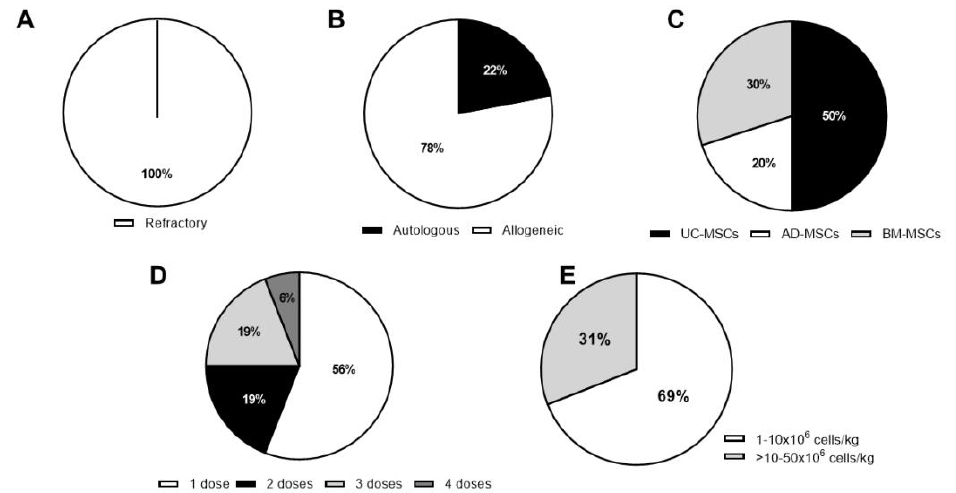
Figure 1. Characteristics of the completed rheumatoid arthritis (RA) clinical trials. ( A ) RA disease status of patients; ( B ) major histocompatibility complex (MHC) context ( C ) MSC tissue source. Umbilical cord (UC-MSCs), adipose tissue (AD-MSCs), and bone marrow (BM-MSCs); ( D ) number of doses and ( E ) MSC dose expressed as number of cells / kg of body weight (1–10 × 10 6 or > 10–50 × 10 6 ). Data are represented as percentage of the total number of